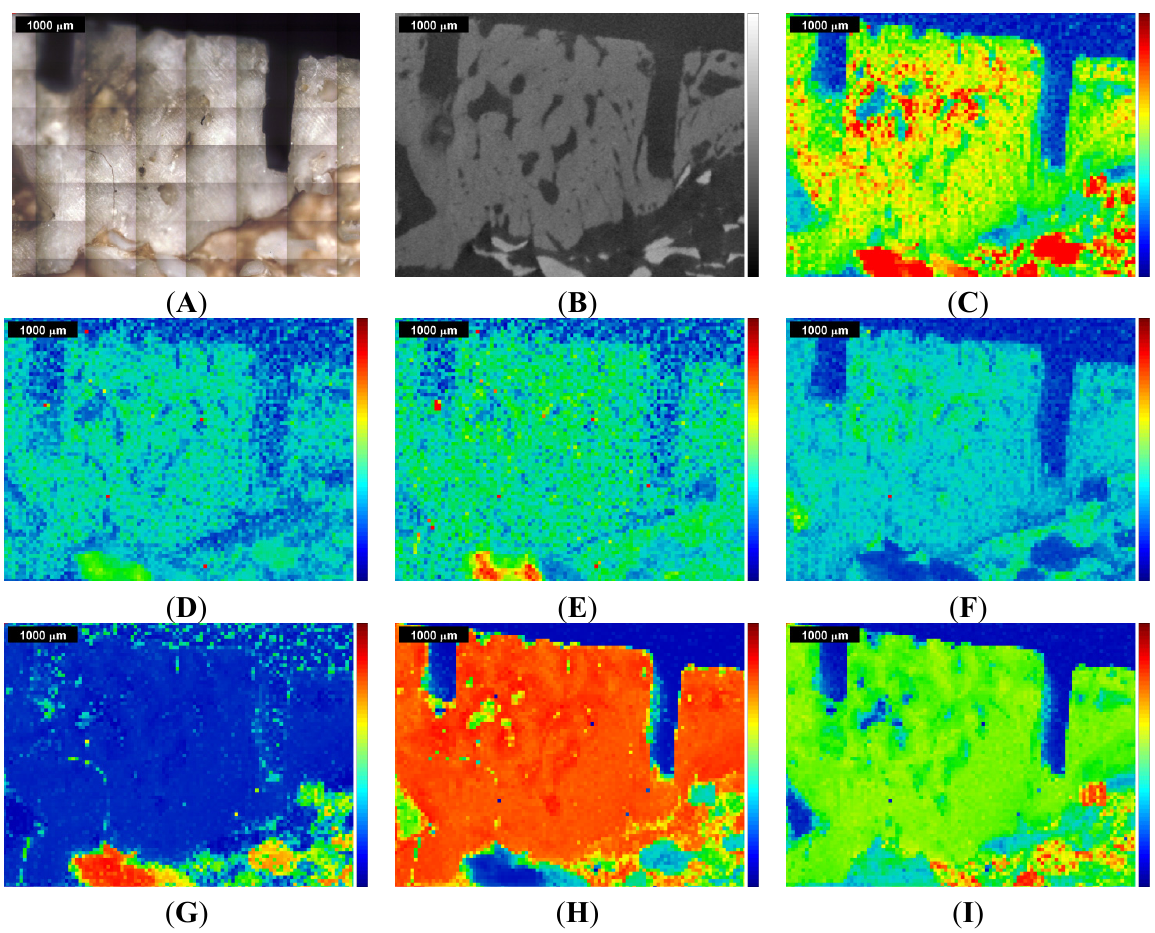
Figure 2. Raman images and correlation maps obtained within ROI 1 from the first measurement of the sinus grafted bone sample (see also Supplementary Materials). Red means high